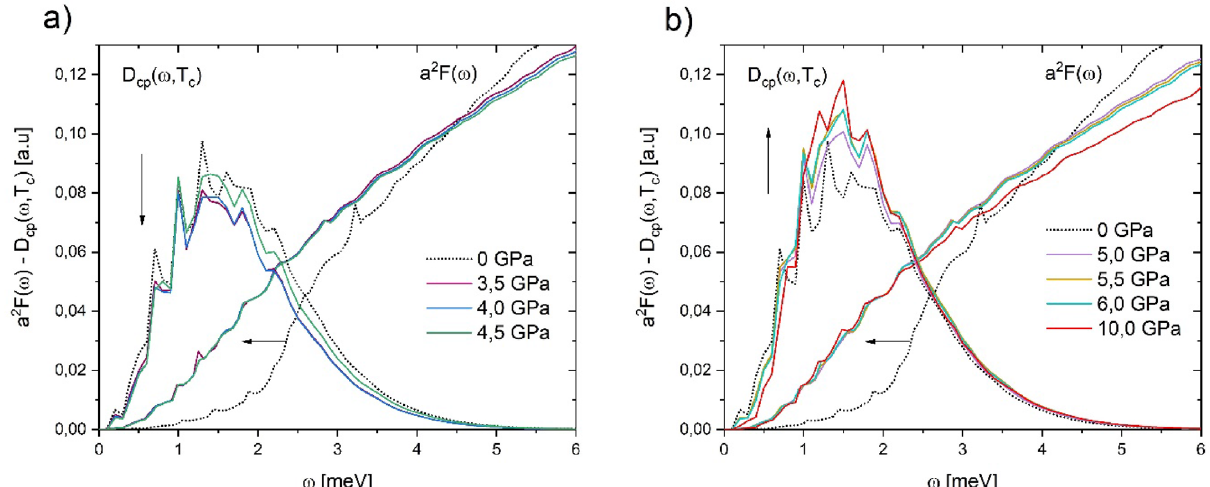
Figure 1. Cooper Pairs Distribution function D cp (ω , T c ) and Eliashberg function for Niobium under pressure. ( a ) 0 − 4.5GPa and ( b ) 5.0 − 10.0GPa . A detailed look of both ( a and b ) shows Eliashberg function smoothing respect to zero pressure, namely Nb anomaly, and their corresponding D cp (ω , T c ) is located on this one.